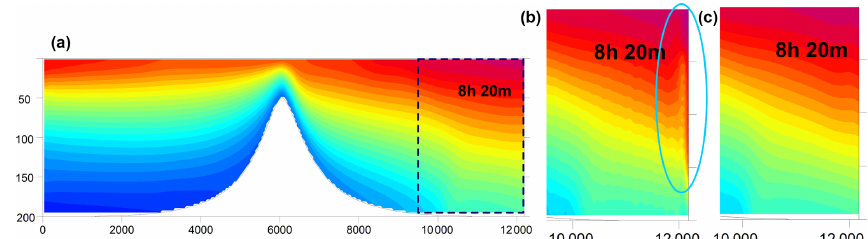
Figure 15. Temperature section along the channel as simulated on the quadrilateral mesh (a) . The two inserts show the area adjacent to the open boundary on the purely triangular mesh (a) and the mesh for which the vicinity of the open boundary is rendered with quads (c) . The dashed rectangle shows the area of the inserts. Numerical instability evolves on a purely triangular mesh (blue